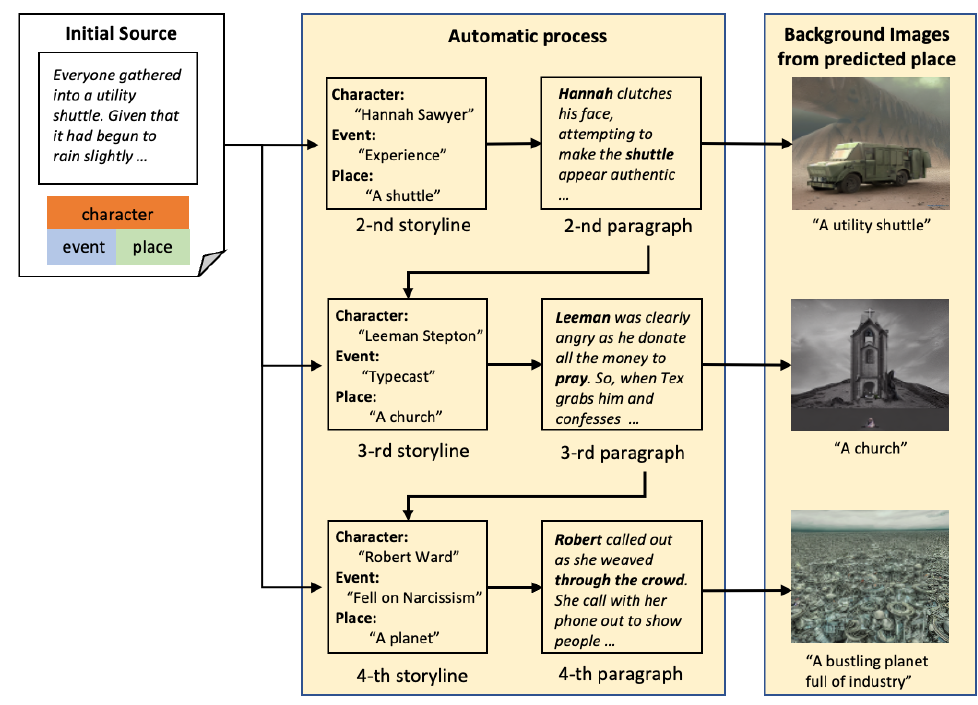
Figure 1. An overview of our